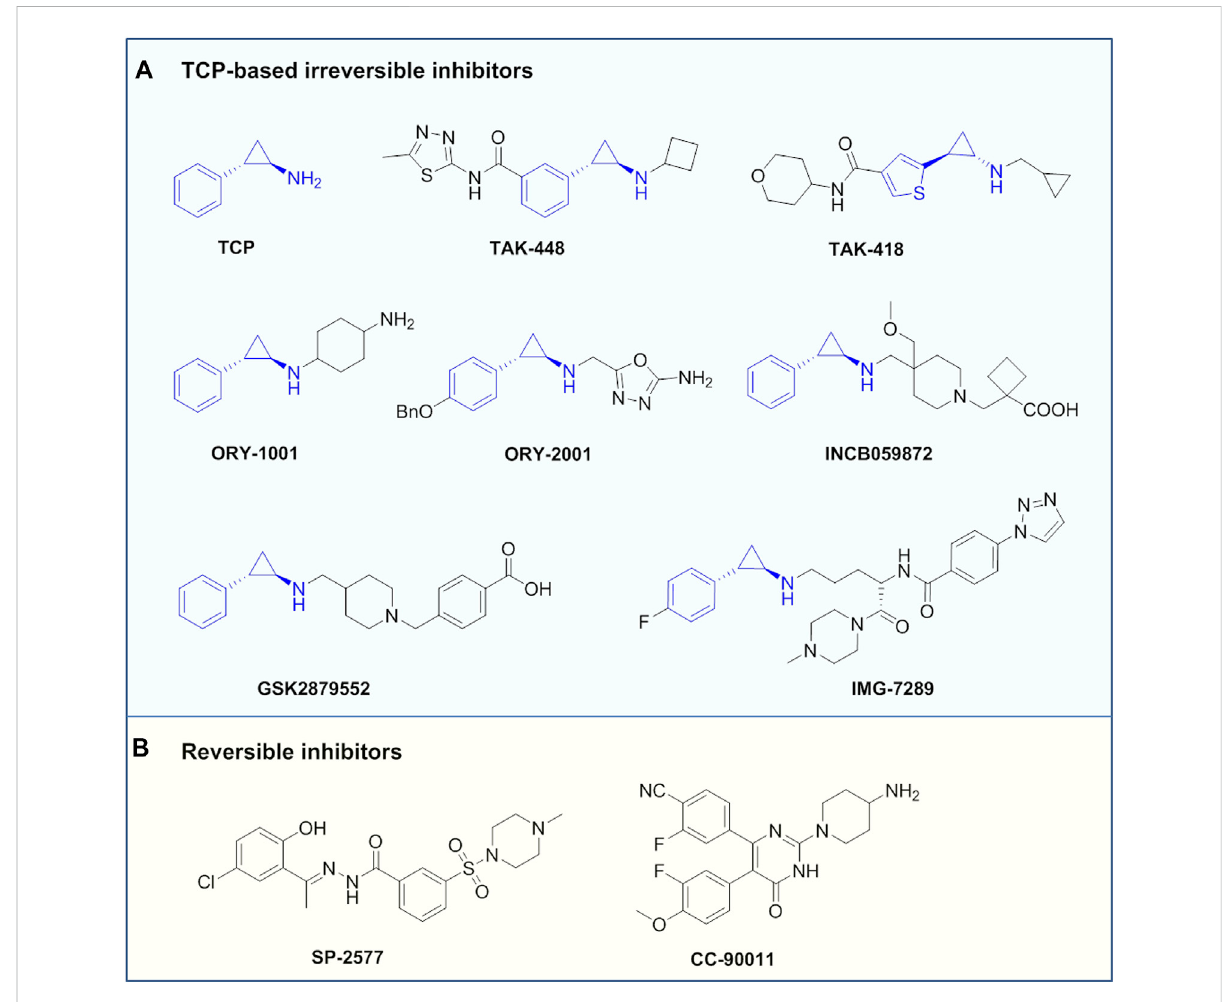
FIGURE 5 Representative LSD1 inhibitors under clinical